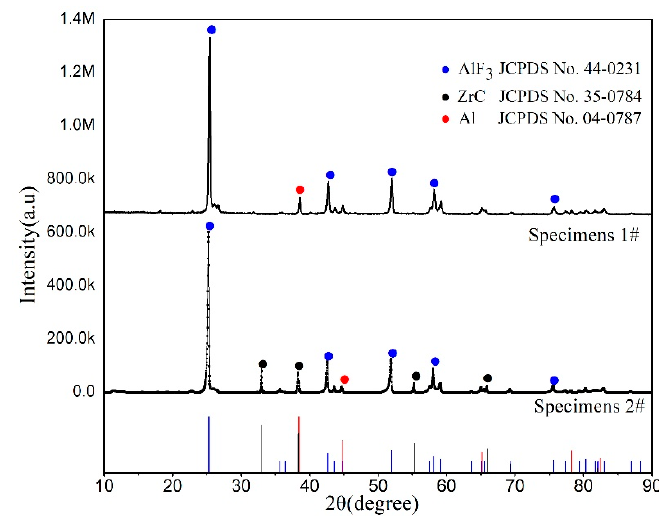
Figure 5. XRD (X-ray diffraction) results of reaction residues.